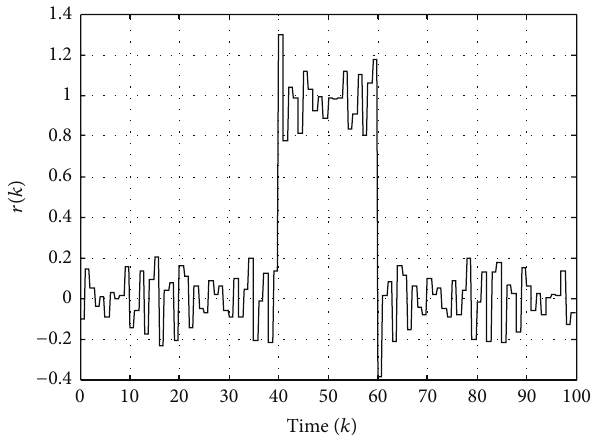
Figure 5: Random parameters 𝜆(𝑘) when 𝜌 = 0.9 .